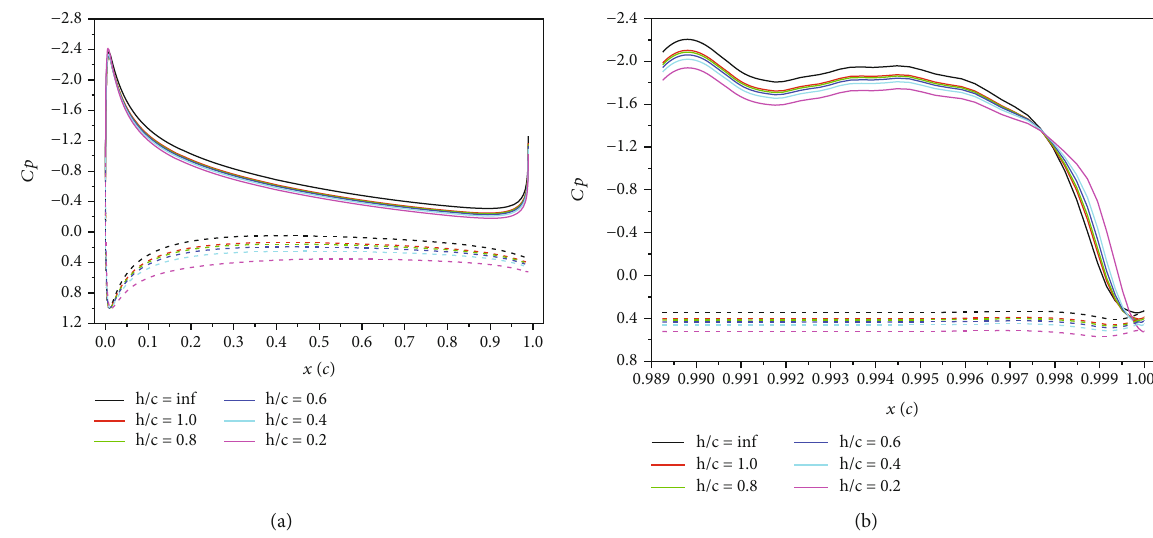
= 0 : 013 at α = 4 ° : (a) pressure coe ffi cient of the main airfoil; (b) pressure μ